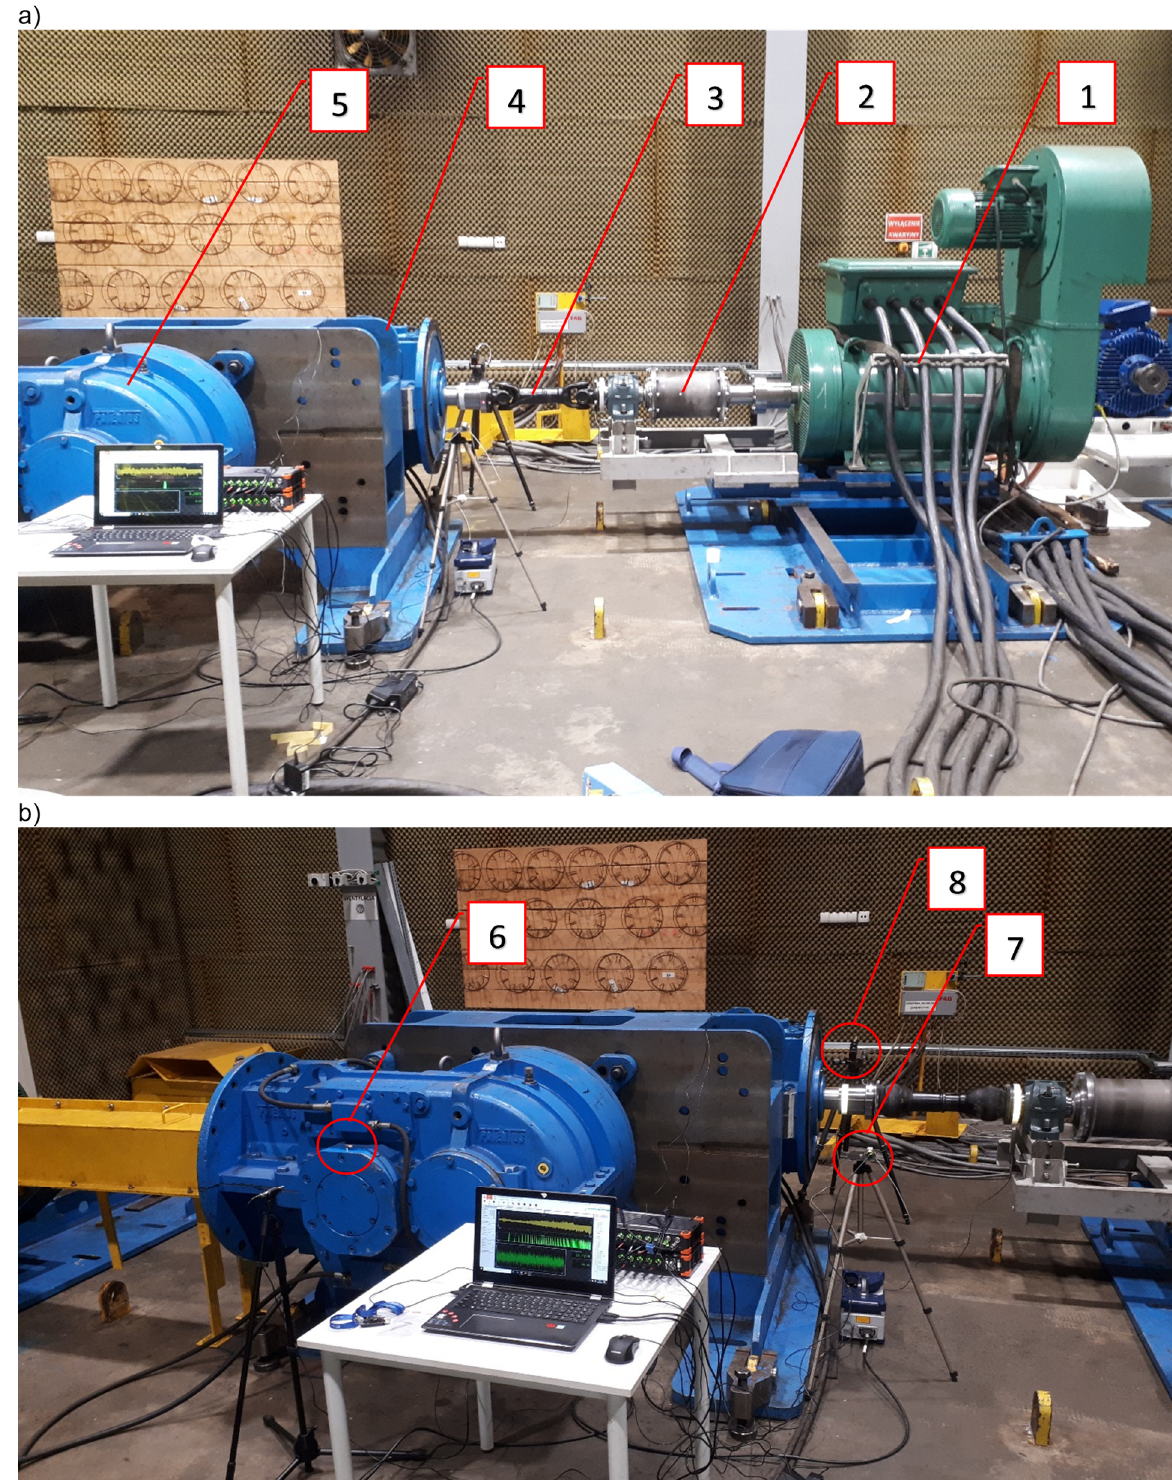
Figure 1. Object of the research: electric motor driving (1), innovative flexible torsion clutch (2), shaft with universal joints (3), set of two multistage gears ((4) and (5)), vibration acceleration converter (6), tachometric sensor (7), and laser vibrometer for non-contact laser measurement of instantaneous angular velocity changes of the shaft by Polytec RLV-5500 (8)—( a , b ) represents different view.